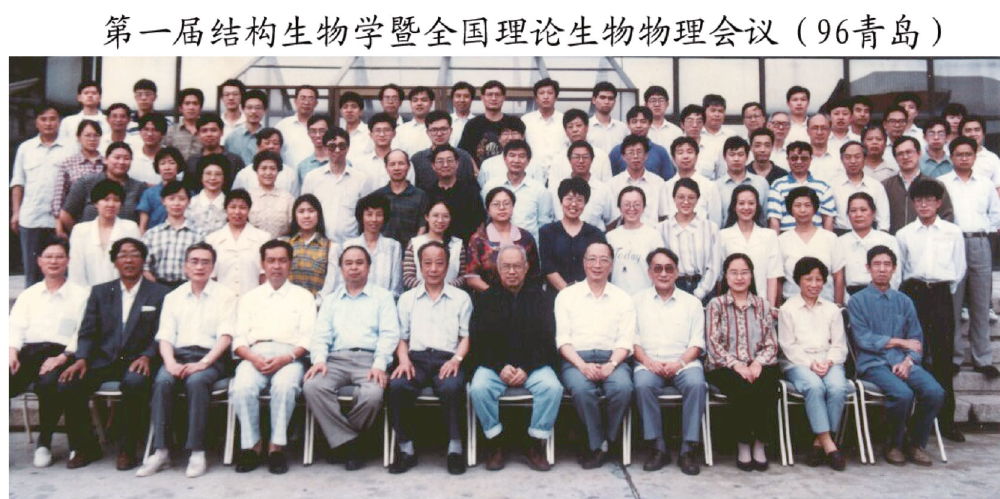
Figure 3. Attending the First Chinese Conference of Structural Biology and Theoretical Biophysics, Qingdao in 1996 (Front row, 6th from the right. Photograph courtesy of Dr. Haixu Tang, Indiana